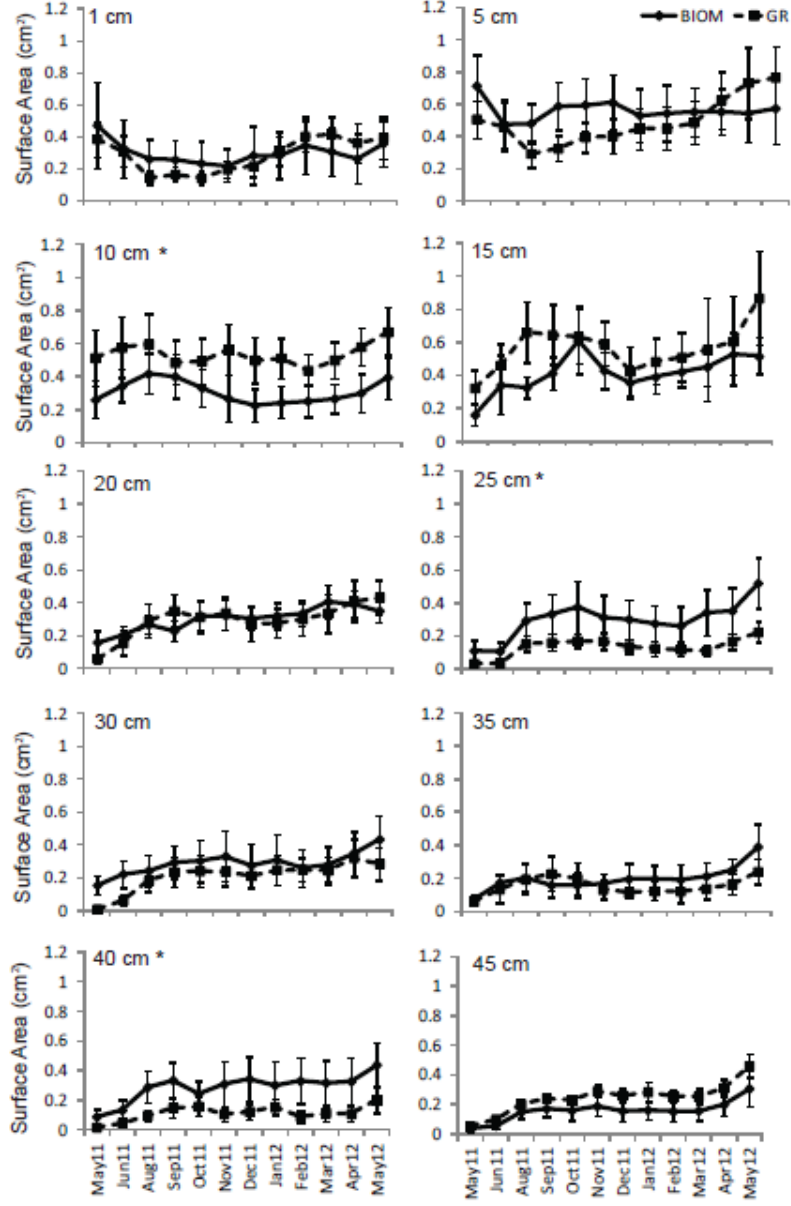
Figure 6. Average total root surface area by month and by minirhizotron tube length (5 cm tube length = 3.5 cm vertical soil depth) in soils under established native pastures managed for grazing (GR) and biomass crop exclosures (BIOM). Asterisks after the minirhizotron length represent depths where the root surface area is different in soils under grazing and biomass production ( p <